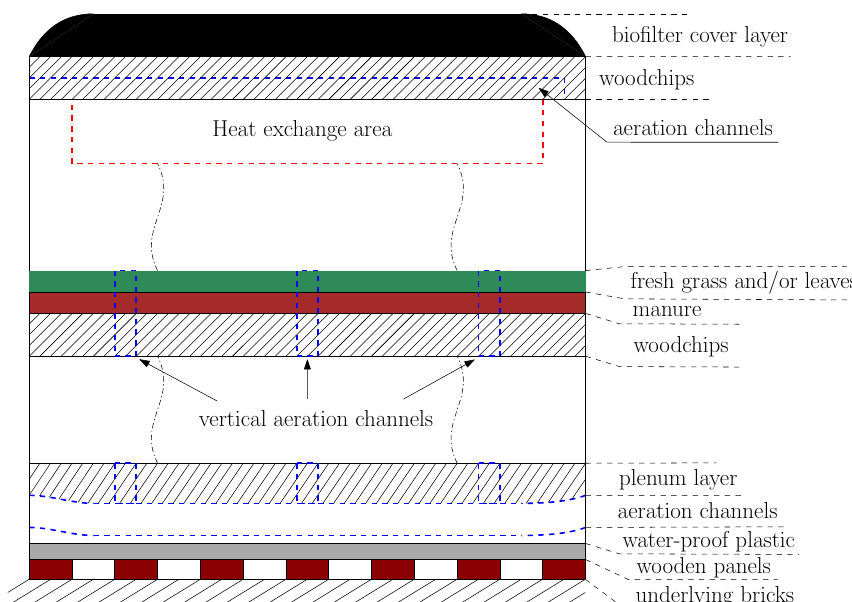
Figure 8. Feedstock layers (schematic drawing—disproportional). Woodchips, manure and fresh green grass and/or leaves are laid consecutively up to the desired height of the